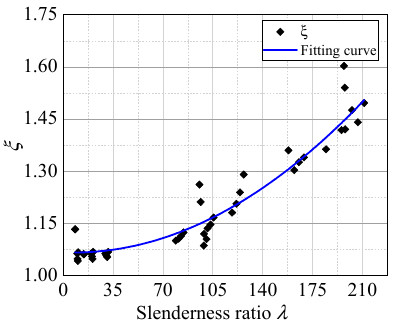
Figure 23. ξ – λ relationship.